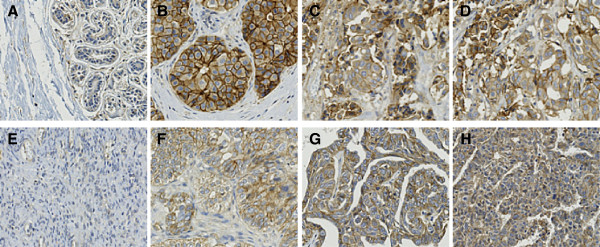
Over-expression of Nectin-2 protein in breast and ovarian cancer tissues. Paraffin-embedded tissue sections were stained with anti-Nectin-2 poAb as described in Methods. A, Normal breast tissue, B–D, breast infiltrating ductal carcinoma tissues. E, normal ovarian tissue, and F–H, ovarian serous carcinoma tissues.